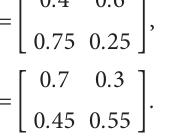
Figure 8: The state trajectories with CF.